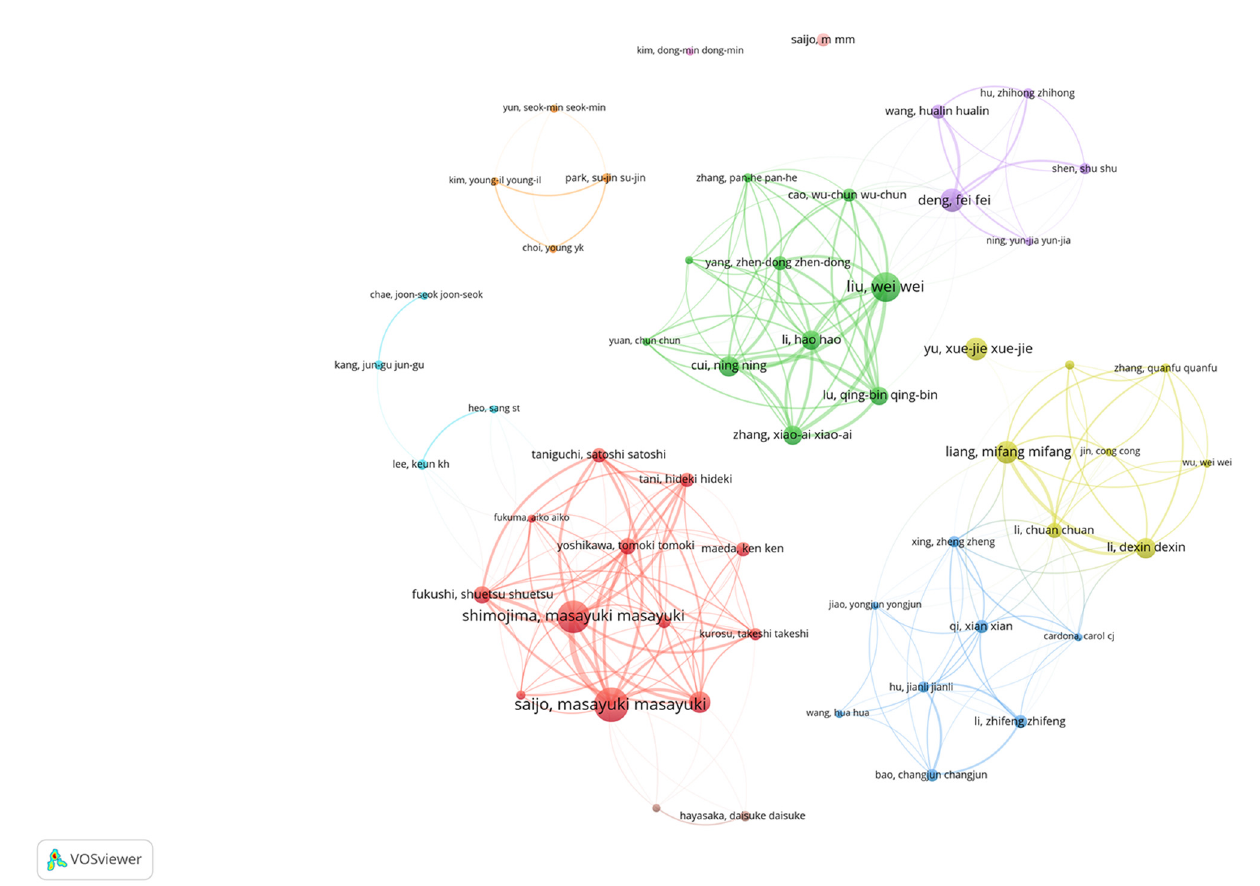
FIGURE5 Cooperation map of 55 authors with the number of publications no less than 5